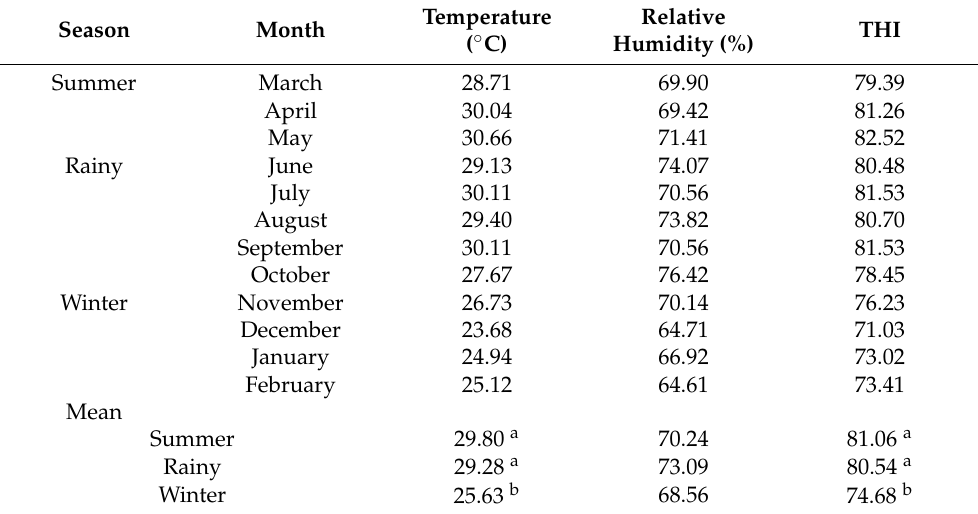
Table 1. Monthly data on each season’s temperature, relative humidity, and THI during the experi- mental period.